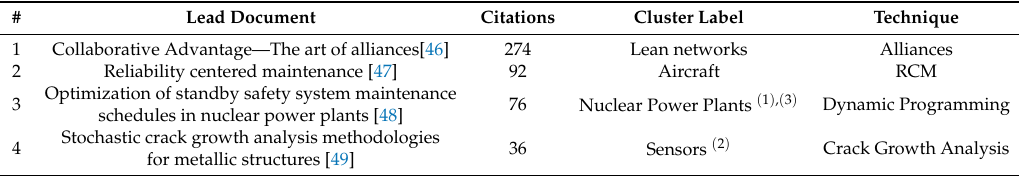
Table 5. Research Front